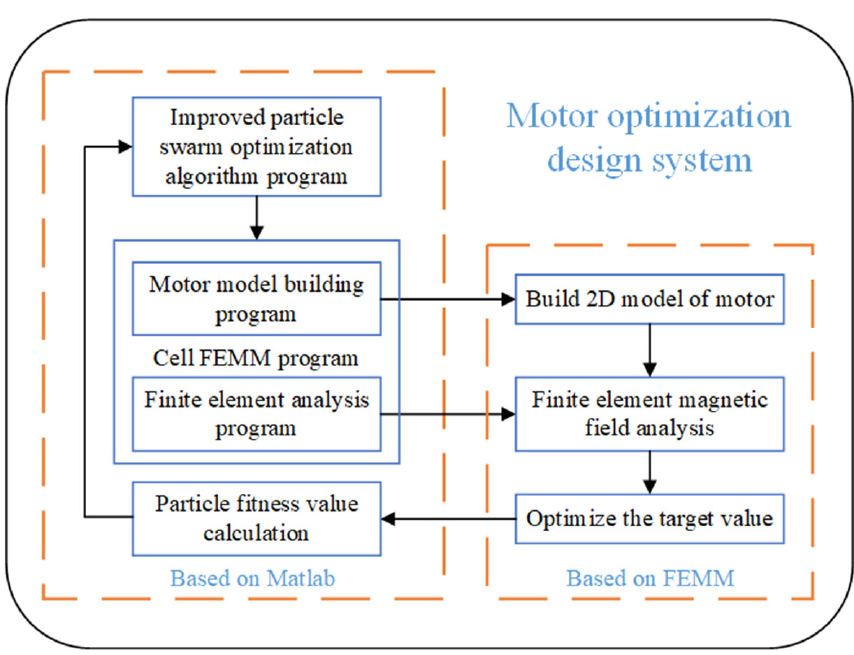
Figure 12. Finite element model of the stepped rotor BLSRM.